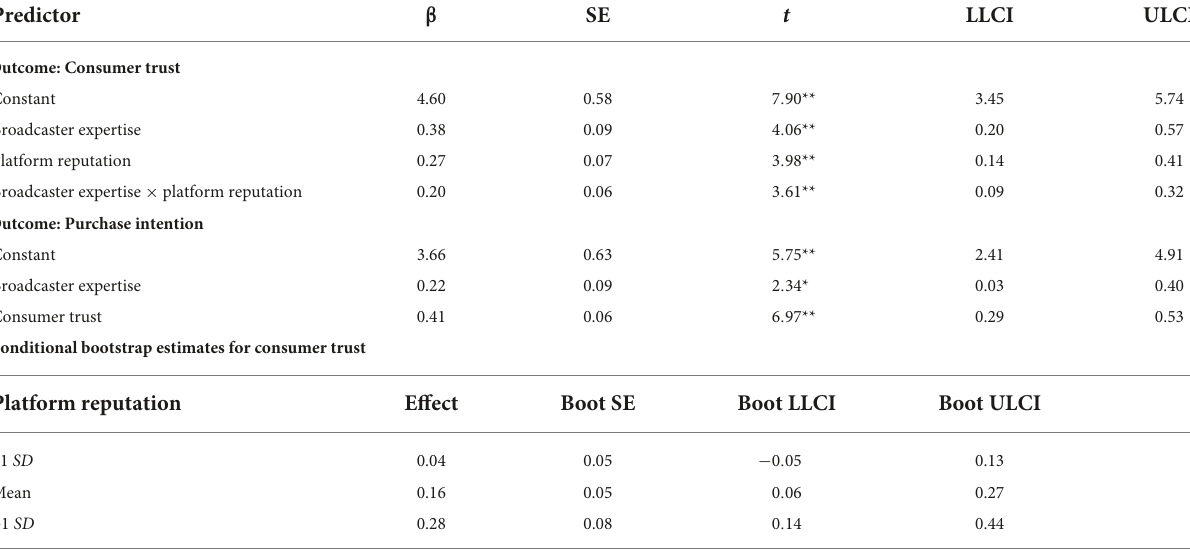
TABLE 4 Moderated mediation analysis examining the impact of platform reputation on the relationship between broadcasters’ expertise and consumers’ purchase intention with consumers’ trust as a moderator. Predictor β